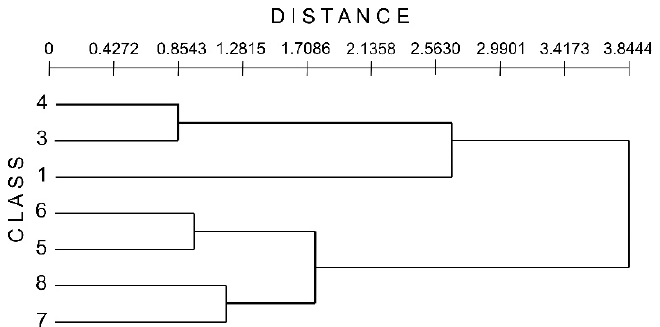
Figure 6. Correlation of determination (R 2 ) for the linear Pearson correlation measure between seven variables created using uISO for NZD and